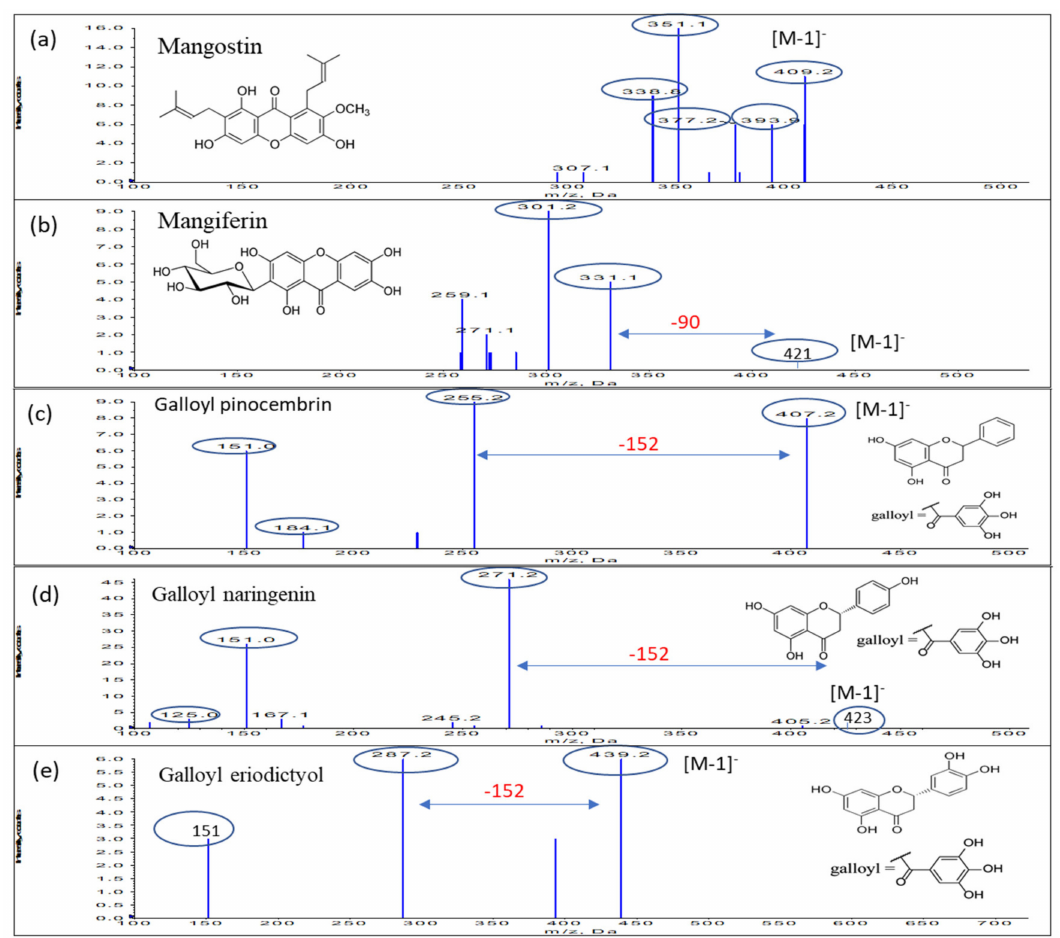
Figure 4. Mass spectra of detected flavanones; ( a ) mangostin, ( b ) mangiferin, ( c ) galloyl pinocembrin, ( d ) galloyl naringenin and ( e ) galloyl eriodictyol in the acidic ethanolic propolis extract. The characteristic ions of the compounds are marked in blue